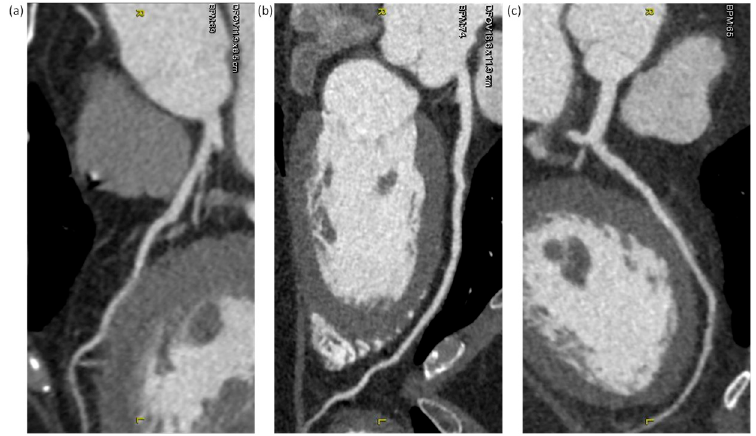
Figure 6. Curved multiplanar reformations of the left anterior descending artery (LAD) subjectively rated at 2. ( a ) Heart rate (HR) = 69 bpm, body mass index (BMI) = 21.6 kg/m 2 , and noise index (NI) = 22.7 HU; ( b ) HR = 74 bpm, BMI = 27.4 kg/m 2 , and NI = 27.7 HU; ( c ) HR = 65 bpm, BMI = 38.2 kg/m 2 , and NI = 38.8 HU.